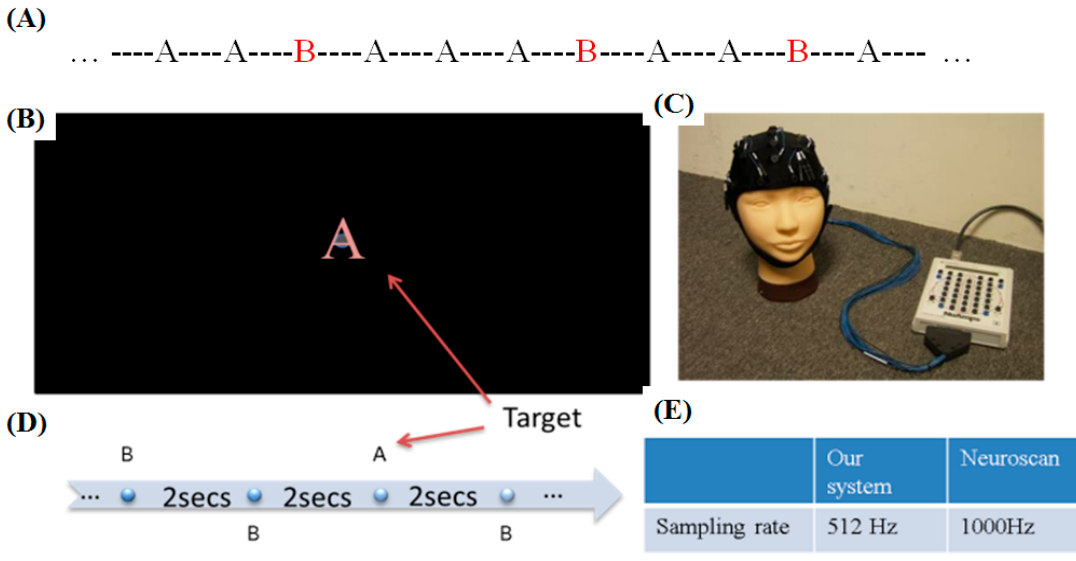
Figure 9. ( A ) A series of random stimuli in the oddball task. ( B–E ) Settings for the event-related potentials (ERP) experiment.